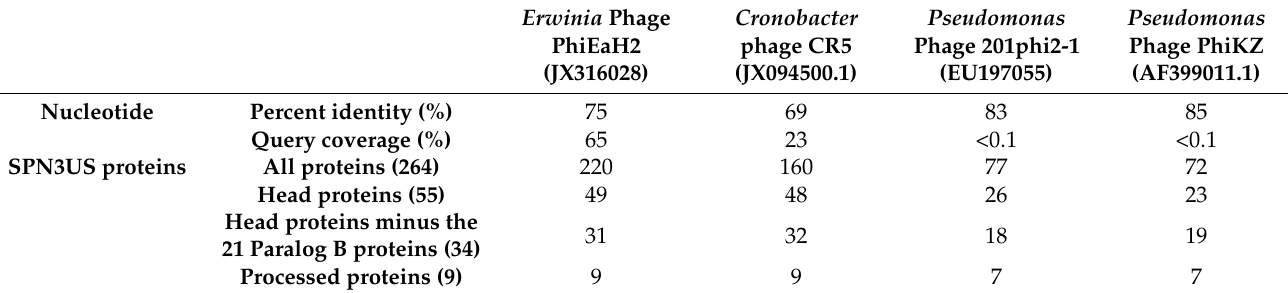
Table 3. Conservation of cleaved SPN3US head proteins in related